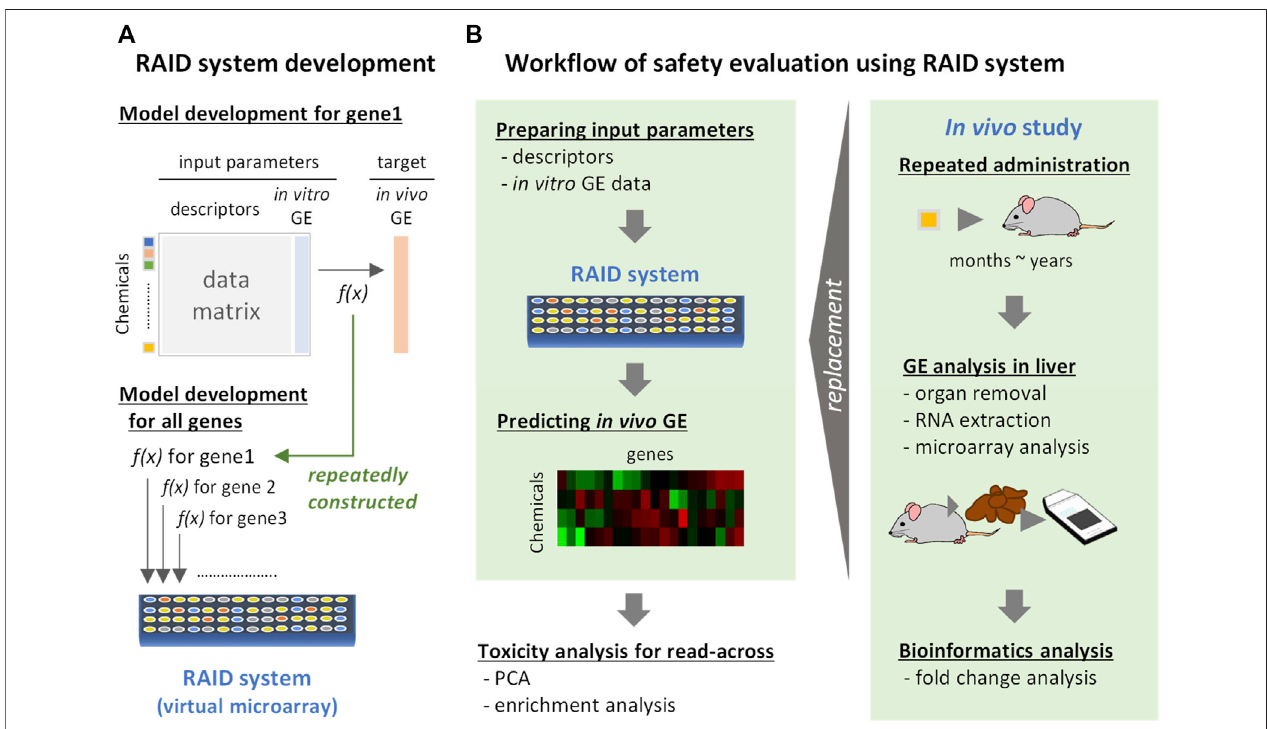
FIGURE1| Developmentandimplementationofavirtualmicroarray(RAID)forread-across.GE:geneexpression.f(x):predictivemodels(formula). (A) RAIDsystem development. The predictive model for in vivo transcriptome data for each gene was individually constructed by elastic net regression employing chemical descriptors and in vitro data. The models constructed were de fi ned as a RAID system (a virtual microarray). (B) Work fl ow of safety evaluation using the RAID system. Chemical descriptors and in vitro gene expression data were inputted to the RAID system and in vivo gene expression data were outputted. The predicted results were analyzed by PCA and enrichment analysis for read-across. This procedure would replace toxicogenomics analysis in in vivo repeated dose study.